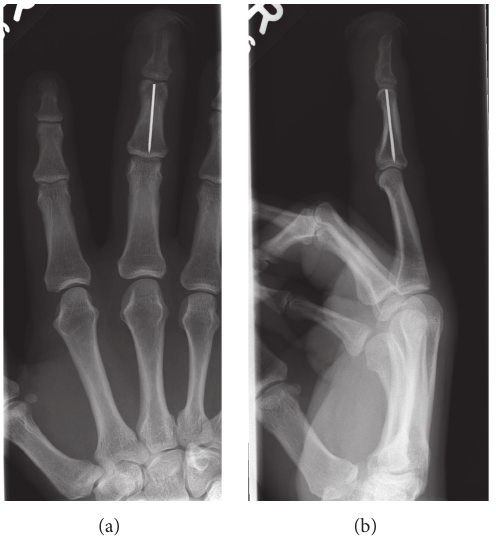
Figure 2: X-rays showing retained Kirschner wire in the right middle finger